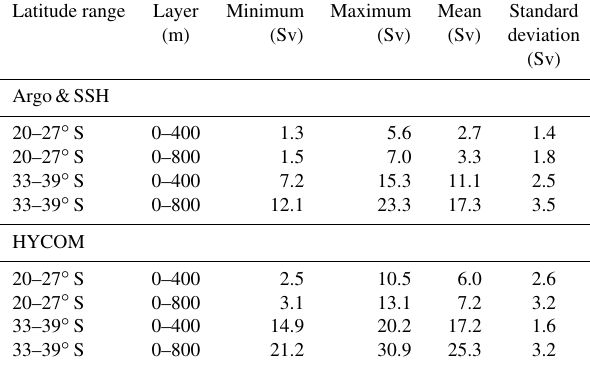
Table 1. Statistics of transports in the Brazil Current region from Argo&SSH and HYCOM in various layers for two latitude